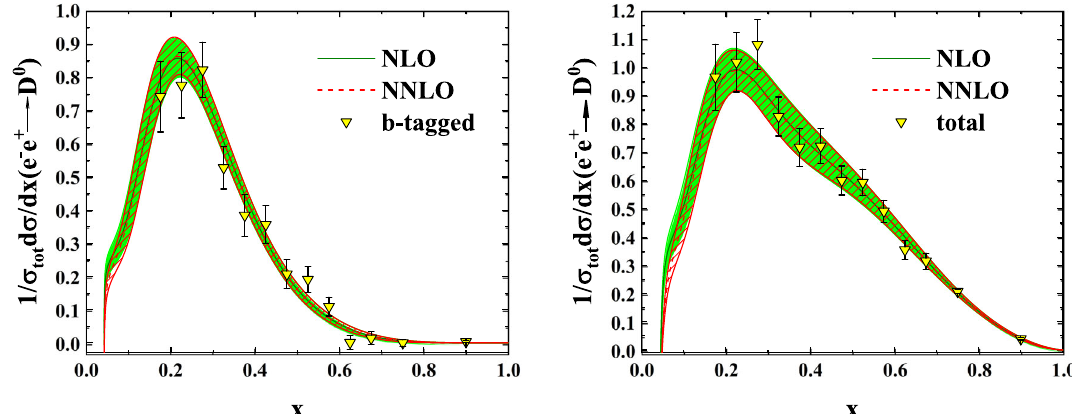
Fig. 3 Our NLO and NNLO theoretical predictions are compared with the normalized inclusive total (left) and b -tagged (right) data sets for D 0 meson production from OPAL experiment